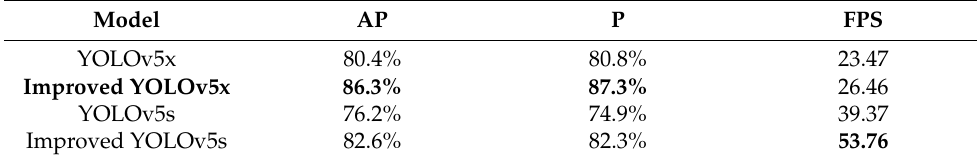
Table 1. Comparison of experimental results.